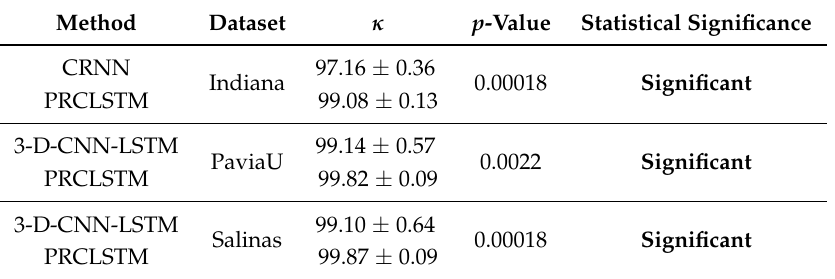
Figure 13. The classification result (%) with a limited size of training samples: ( a ) OA, ( b ) Kappa Coefficent ( κ ), and ( c ) Average Accuracy (AA). Table 10. The statistical significance of the PRCLSTM and the best competitors on the datasets in